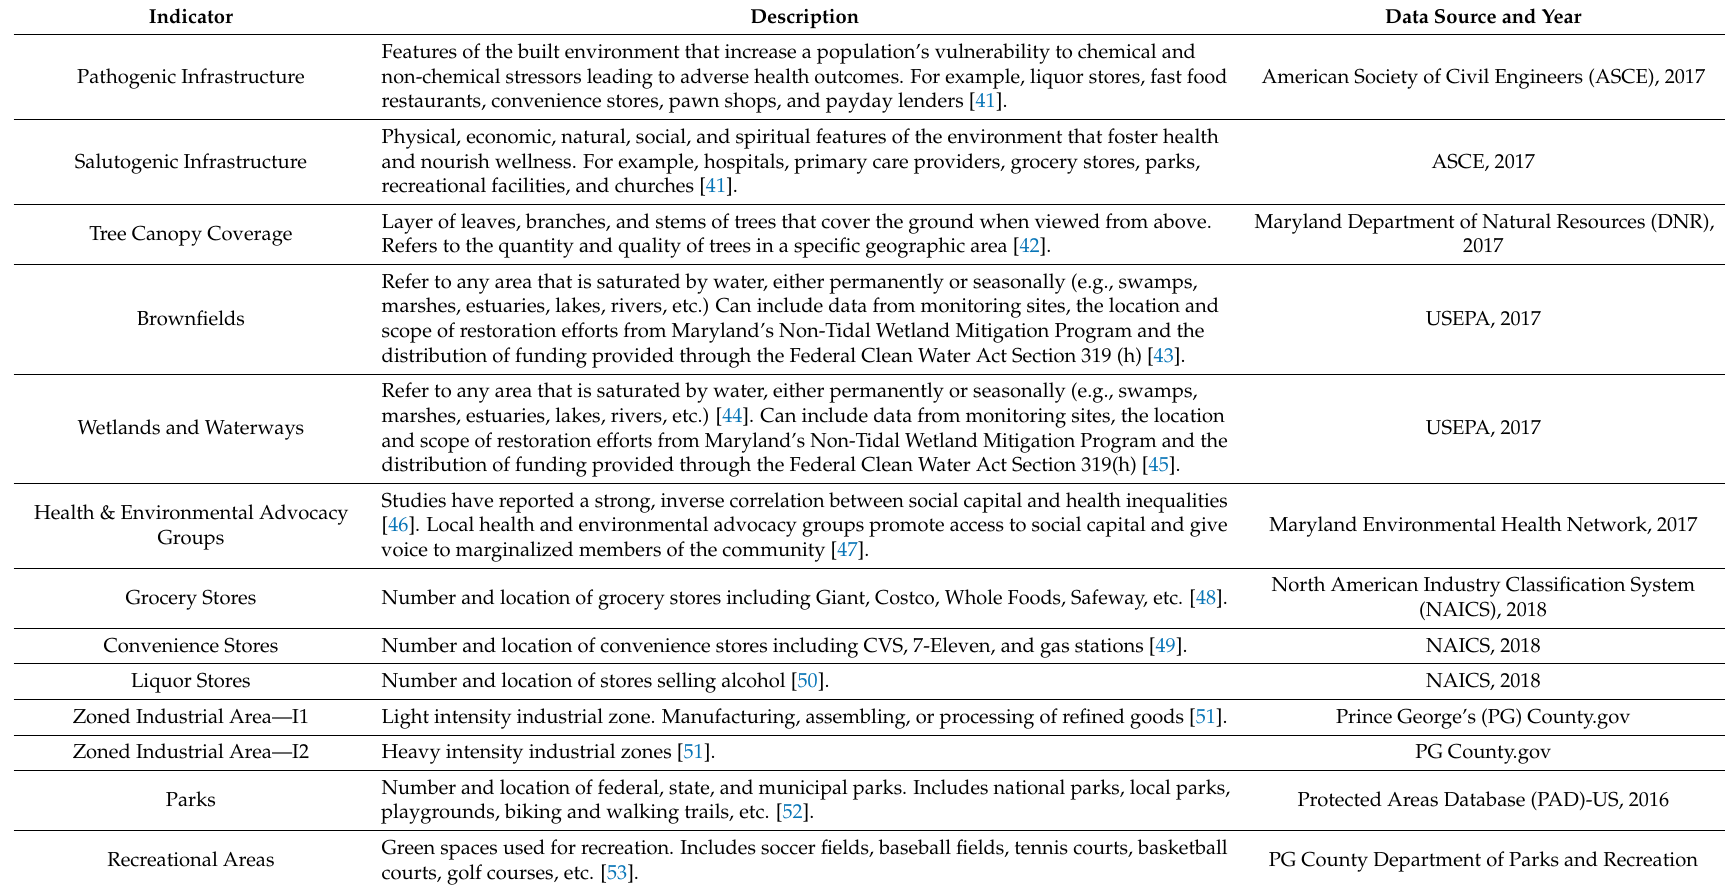
Table 2. Additional indicators in MD EJSCREEN tool promoted by